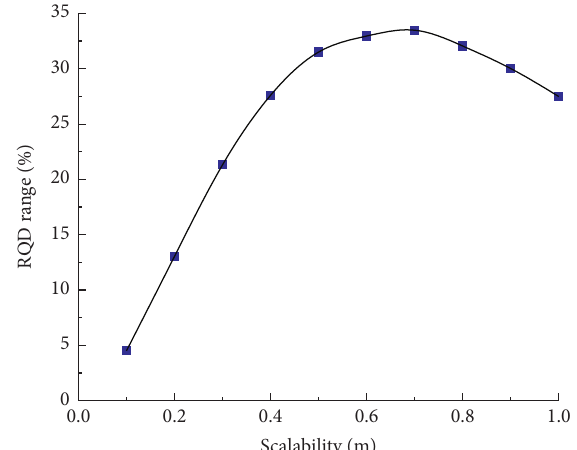
Figure 5: RQD range for different thresholds (spacing: 1 m; trance length: